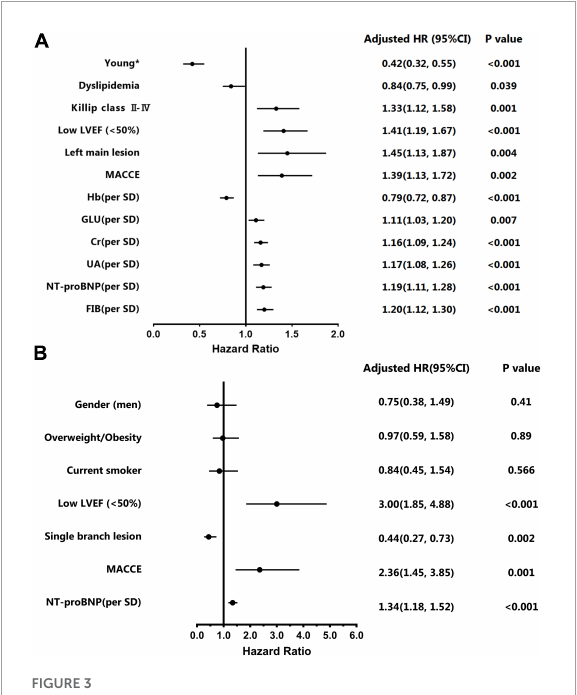
FIGURE3 Multivariate Cox regression models for overall and premature acute myocardial infarction (AMI) patients. (A) Adjusted Hazard ratios and 95% confidence intervals of multivariate for overall patients. (B) Adjusted Hazard ratios and 95% confidence intervals of multivariate for young patients. *The group aged < 55 years in men and < 65 years in women.